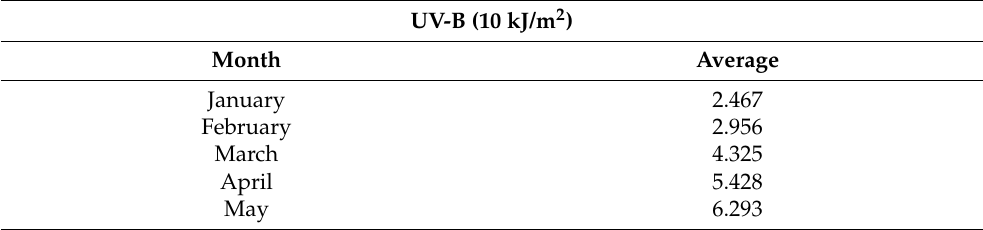
Table 3. Monthly average UV-B radiation for the period January–May